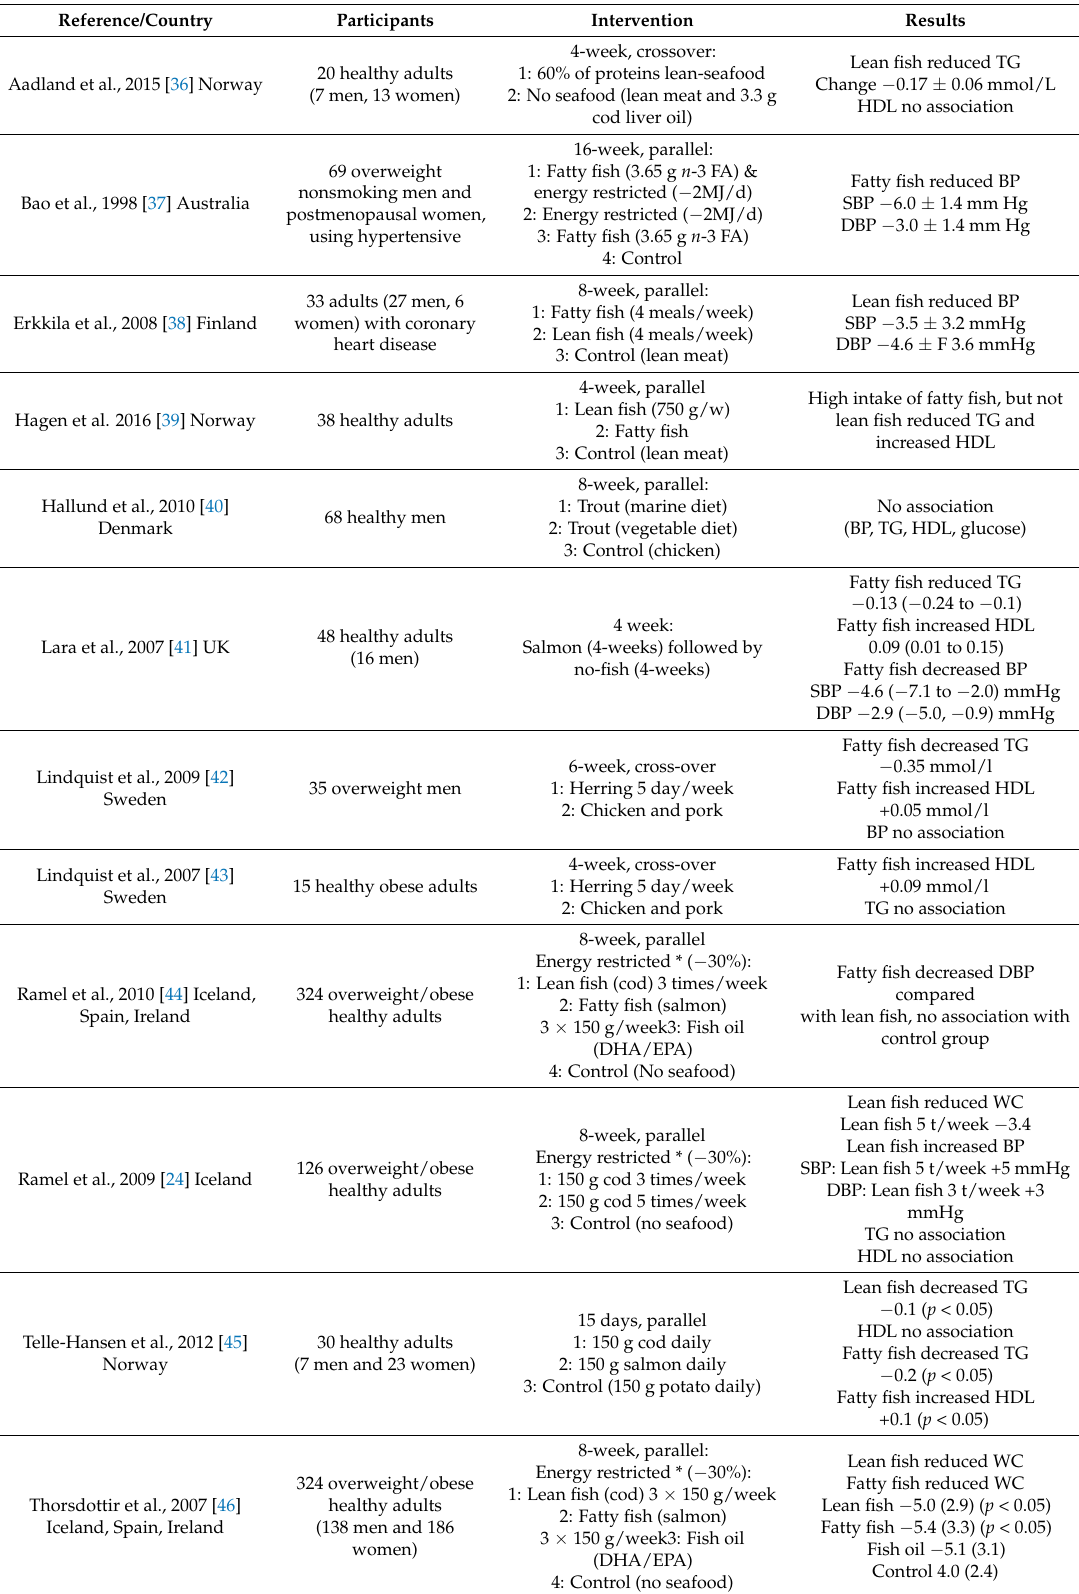
Table 3. Intervention studies on fish consumption and the metabolic syndrome risk